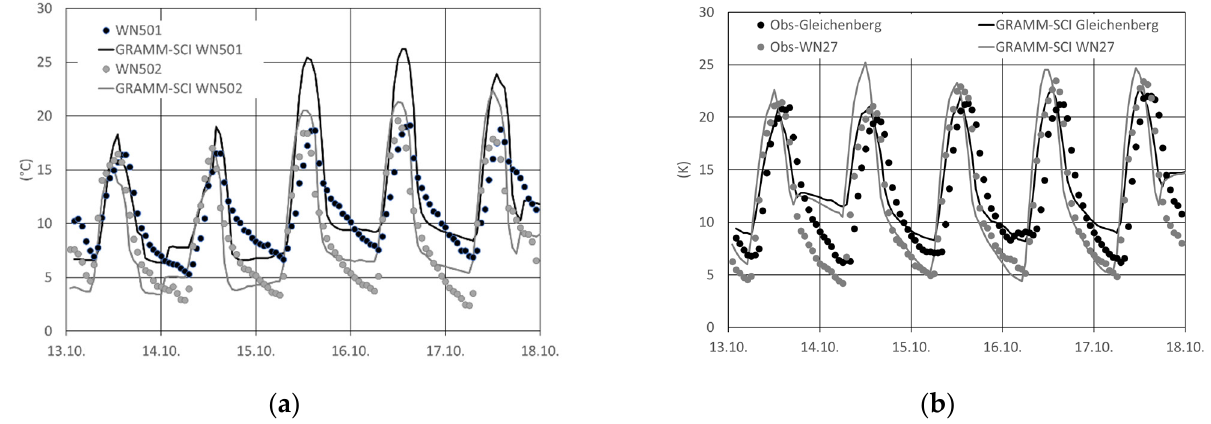
Figure 7. Observed and modelled air temperatures at selected sites in the Johnsbach ( a ) and Feldbach ( b ) domains.